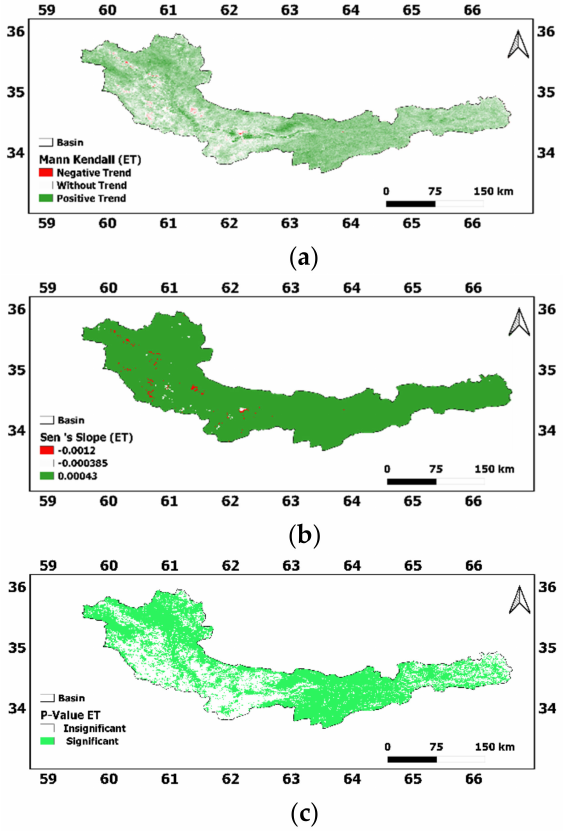
Figure 10. ( a ) Spatial distribution map of trend of annual evapotranspiration (mm) over the Doosti Dam’s basin based on MODIS evapotranspiration dataset (MOD16A2) using Kendall estimator, ( b ) spatial distribution of trend intensity of evapotranspiration (mm) using Sen’s slope estimator (Z = 1.96 at 95% confidence level), ( c ) spatial distribution of trend significance using p factor, over the 18-year period (2004–2021) for the Doosti Dam’s